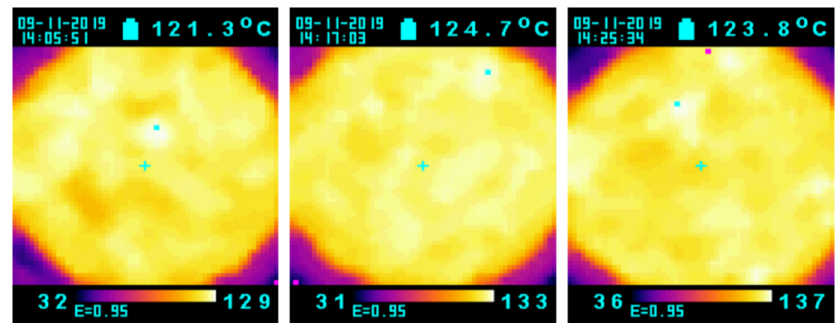
Figure 6. The surface temperature of 1 kg almonds after 5 kW, 40.68 MHz RF roasting ( left : 9 cm gap, 3 min; center : 10 cm gap, 3.5 min; and right : 11 cm gap, 4 min).